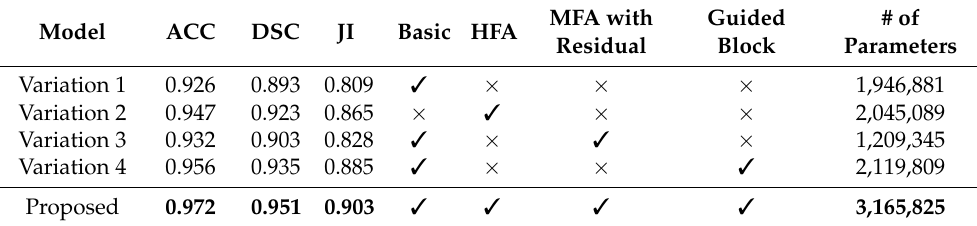
Table 2. Comparison of the proposed method and its variations for skin-lesion test